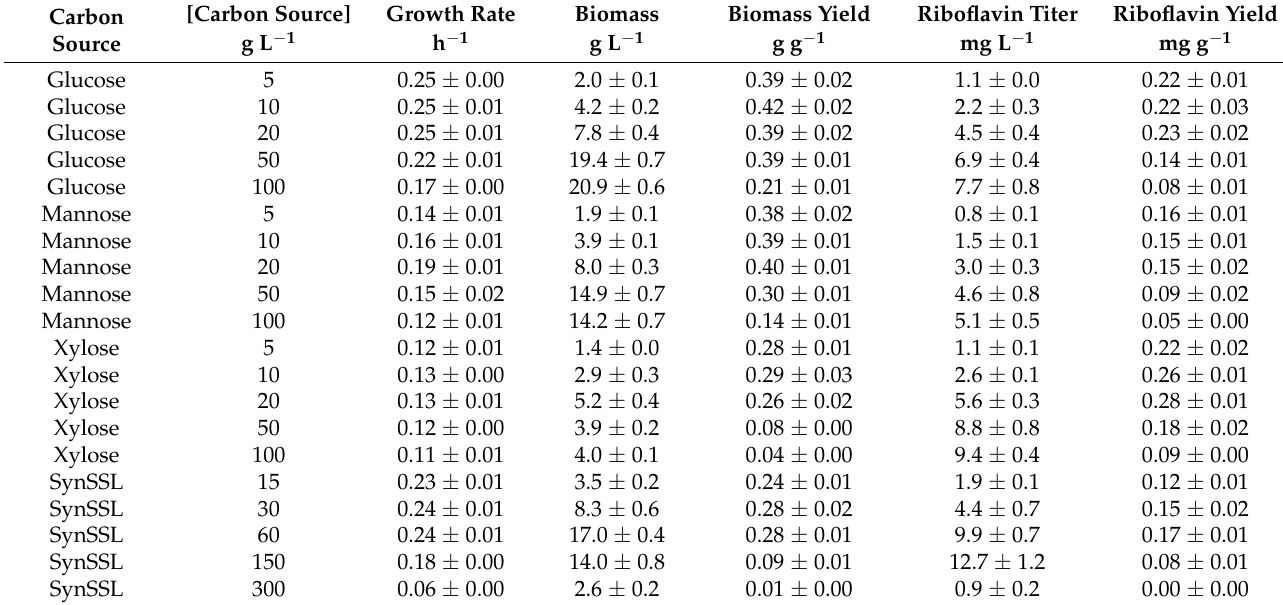
Table 3. Growth and production values of various riboflavin producing strains in shake flask cultivation with different concentrations of glucose, mannose, xylose, and